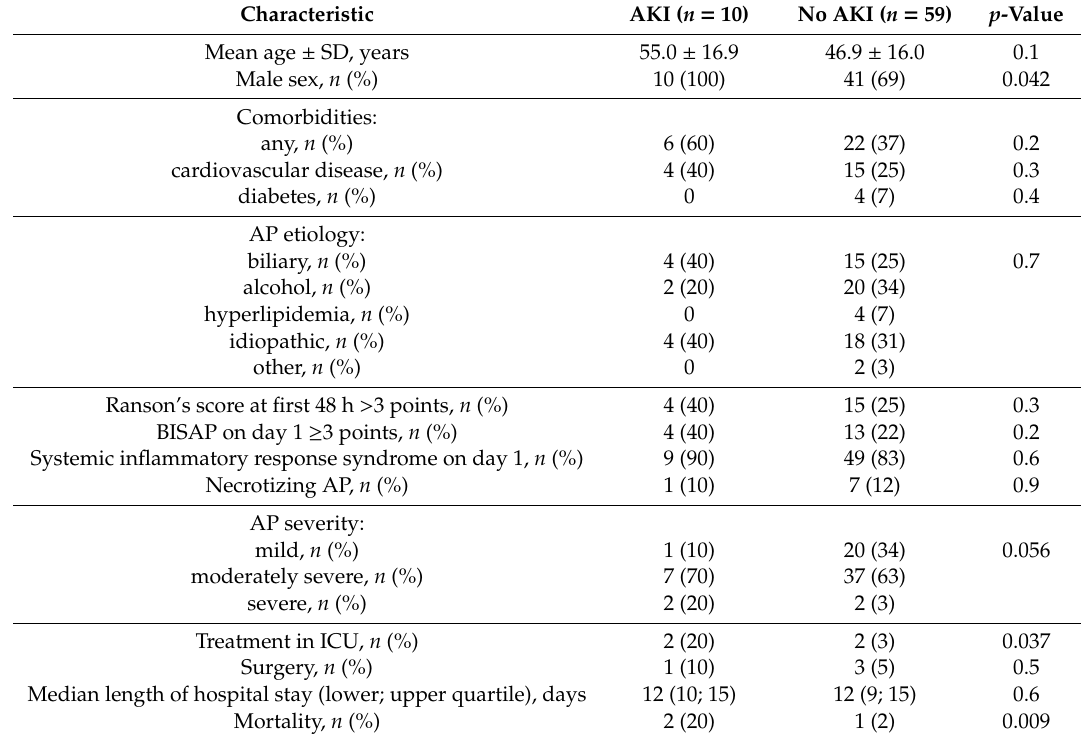
Table 1. Clinical characteristics of studied patients with acute pancreatitis.